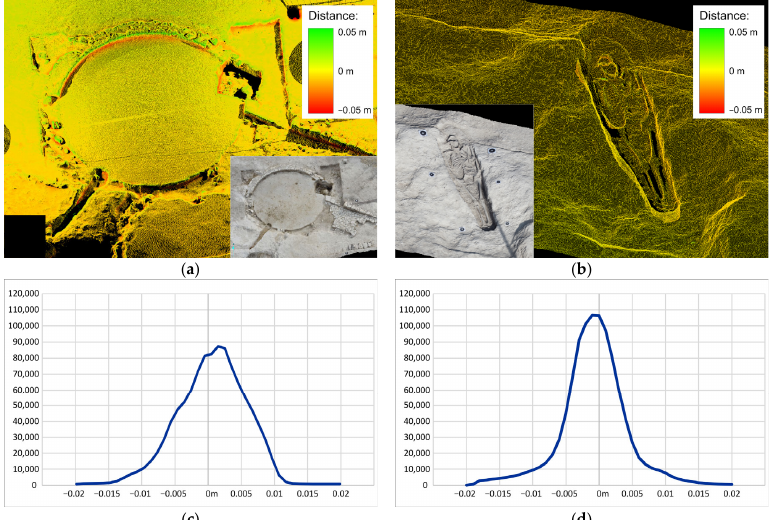
Figure 6. Comparison of TLS point clouds and 3D models obtained by photogrammetry: ( a , b ) distances from TLS points to 3D models; ( c , d ) frequency graphs of the cases ( a , b ). One of the main goals of this study was the analysis of the evolution of the archaeo ‐ logical work carried out during test excavations. In this sense, Figure 7 shows several DEMs and 3D models regarding several stages of the archaeological work. Thus, Figure 7a shows a representation of four DEMs modelling the evolution of an archaeological test during the intervention. The documentation of each stage was decided following certain archaeological criteria. Figure 7b shows a 3D model obtained after the excavation process (S4) of an excavation test. The consequences on the modelling of the removal of material are displayed in Figure 7b, where the distances from this 3D model with respect to the initial situation are represented. In this case, the volume of excavation achieved was about 133.9 cubic meters. Considering another scale level (SL3), the comparison of the 3D model of one Visigoth burial once it was excavated (Figure 7c) with the initial state of this area shows a volume of excavation of about 2 cubic meters (Figure 7c). The volume estimation between 3D models was based on the distances calculated from a set of points extracted from a regular grid, previously obtained from one 3D model, with respect to the other 3D model. We used Maptek Point Studio software to calculate these distances. The volume was calculated considering the area of the zone and the average distance value. Another example of the evolution of the archaeological work is available in https://youtu.be/KdCCwNK ‐ AWU, accessed on 16 February 2023.